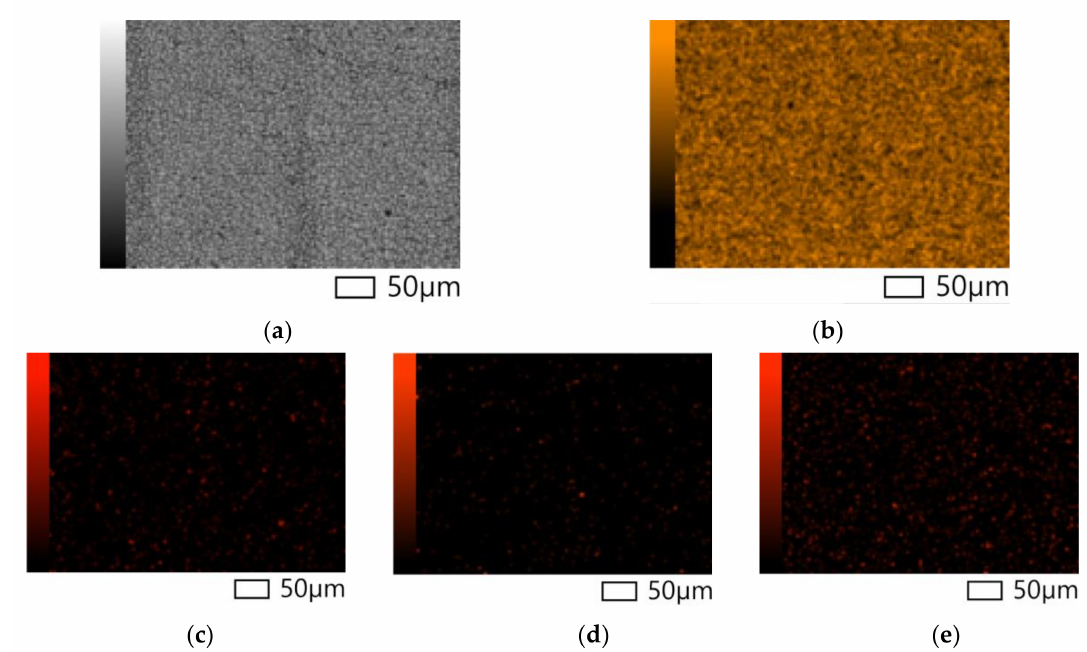
Figure 7. Analysis of the distribution of chemical elements on the surface of the sample undergoing laser cutting. ( a ) SEM photo of the sample, ( b ) Si surface distribution, ( c ) C surface distribution, ( d ) O surface distribution, and ( e ) N surface distribution.